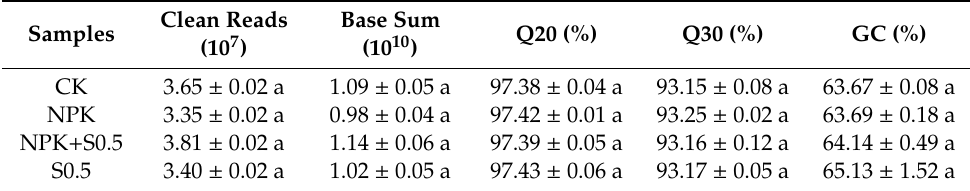
Table 1. Summary of numerical data for metagenomic sequencing.